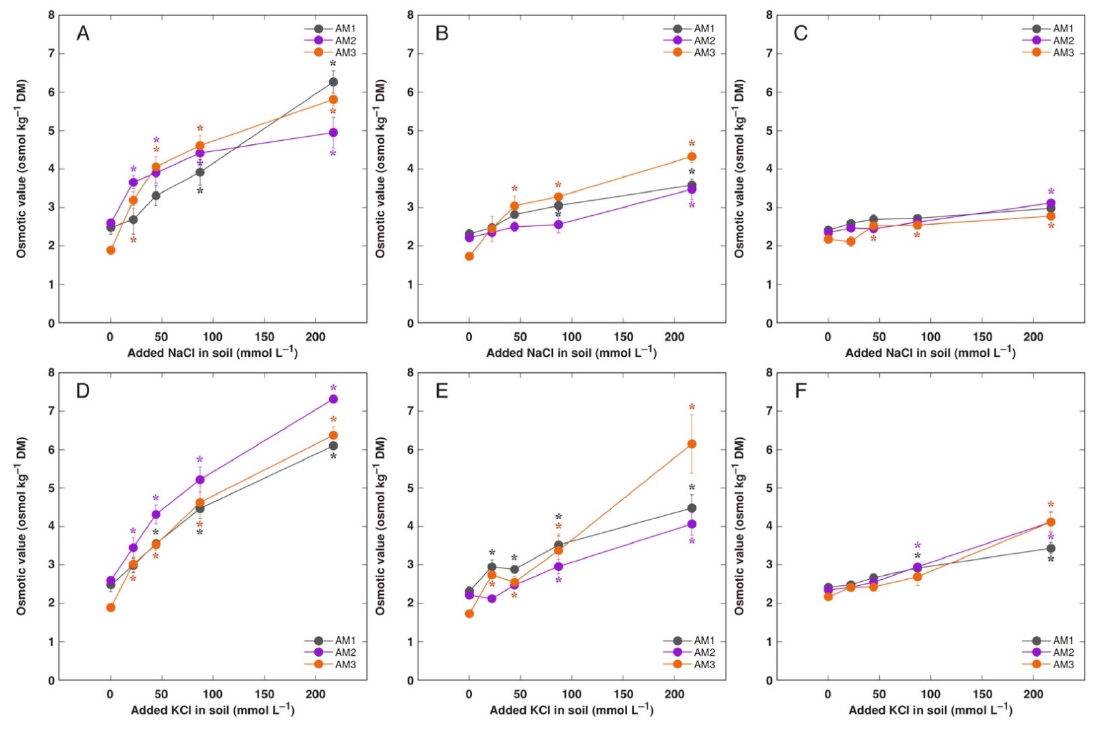
Figure 9. Effect of added NaCl ( A – C ) and KCl ( D – F ) concentration in soil on osmotic value in old leaves ( A , D ), new leaves ( B , E ) and flowers ( C , F ) of Armeria maritima plants from different accessions after 7–8 weeks of cultivation. DM, dry mass. Data are means ± SE from 3 replicates. Asterisks of respective color indicate statistically significant differences ( p < 0.05) from control.